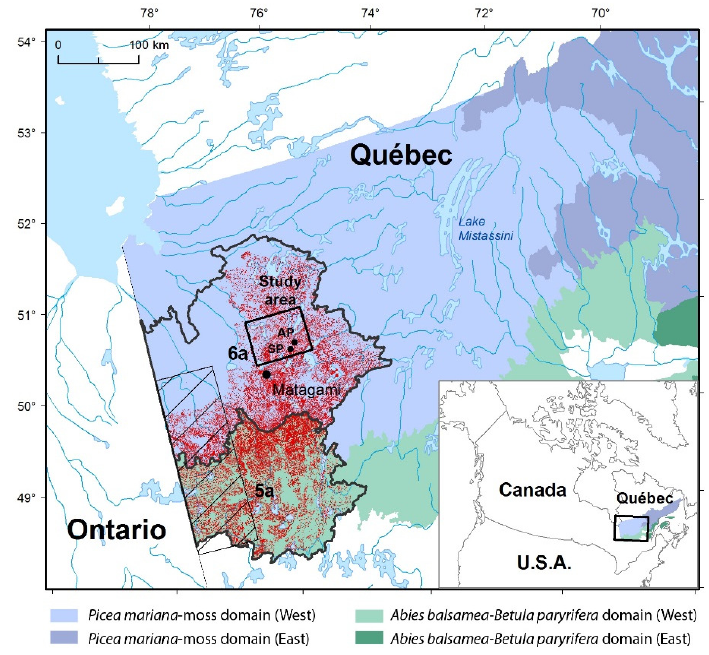
Figure 1. Location of the study area (4000 km 2 ) in Québec’s Picea mariana -moss bioclimatic domain, Canada [4]. The study area is located in ecological region 6a (Plaine du lac Matagami). The two peatlands studied are codified as: AP: Aspen peatland and SP: Shadow peatland. Ecological region 5a (Plaine du lac Abitibi) is part of the western Abies balsamea-Betula papyrifera bioclimatic domain. The sector with oblique lines located close to the border with Ontario corresponds to the fire origin map created by Bergeron et al. [7]. The red dots indicate the clay deposit distribution (QMFFP forest maps) corresponding to Québec’s Clay Belt.